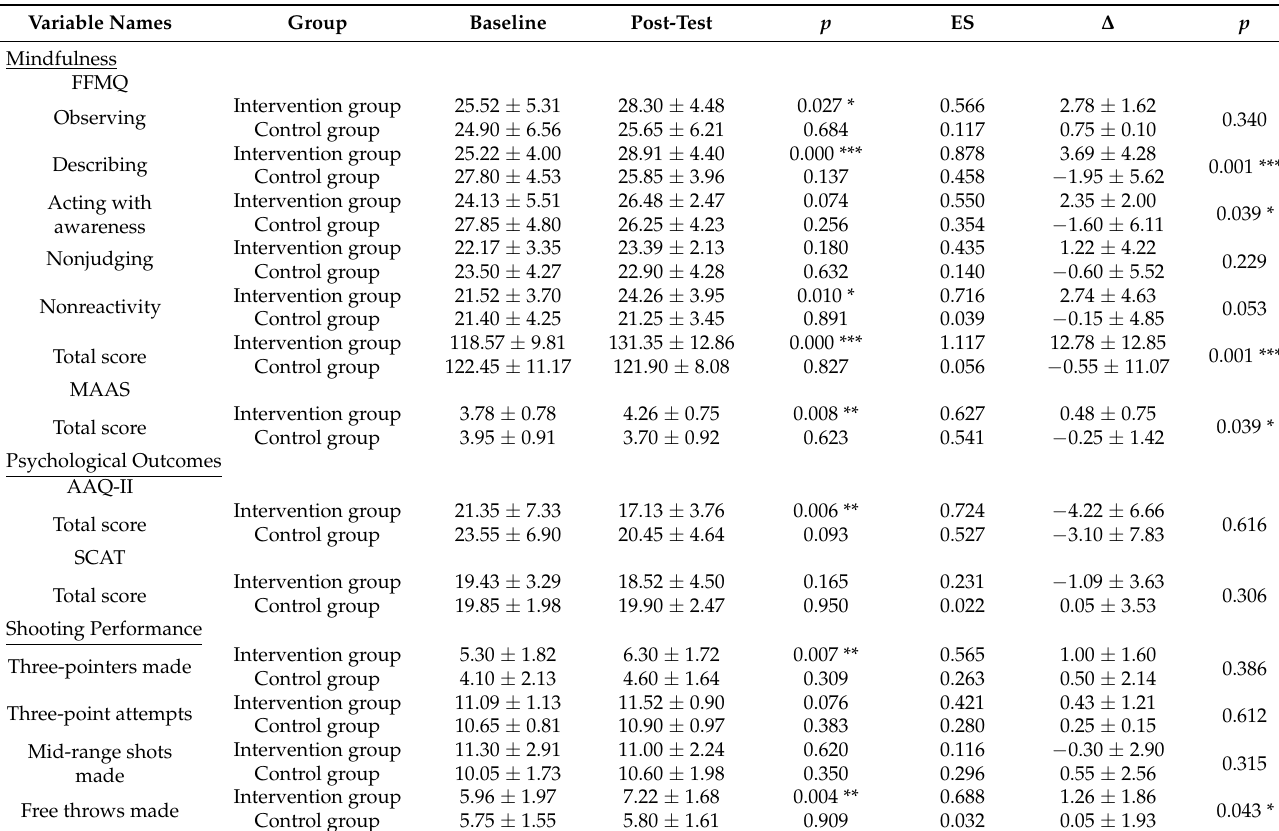
Table 4. Difference between baseline and post-test between two